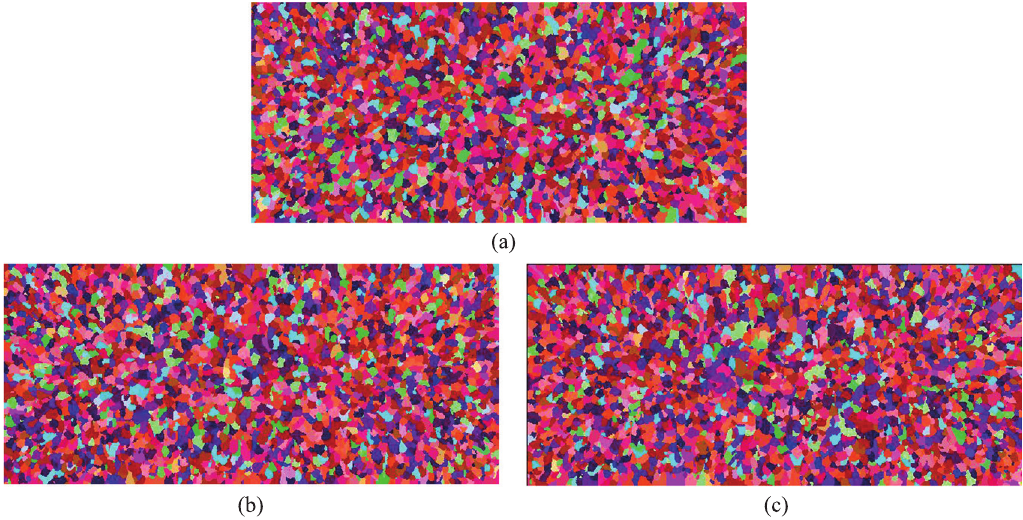
Fig. 6: The simulated solidification structures of center equiaxed grain zone under different secondary cooling water intensities: (a) 1.1 m/ min, 0.9 L/kg, (b) 1.1 m/min, 1.1 L/kg, (c) 1.1 m/min, 1.3 L/ kg